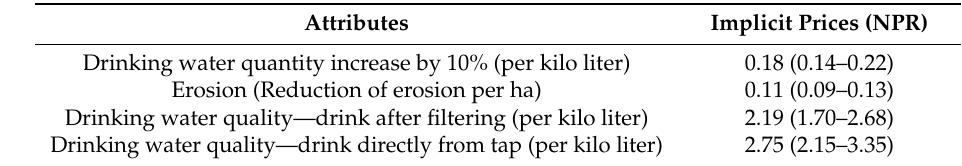
Table 4. Implicit prices and their confidence intervals of